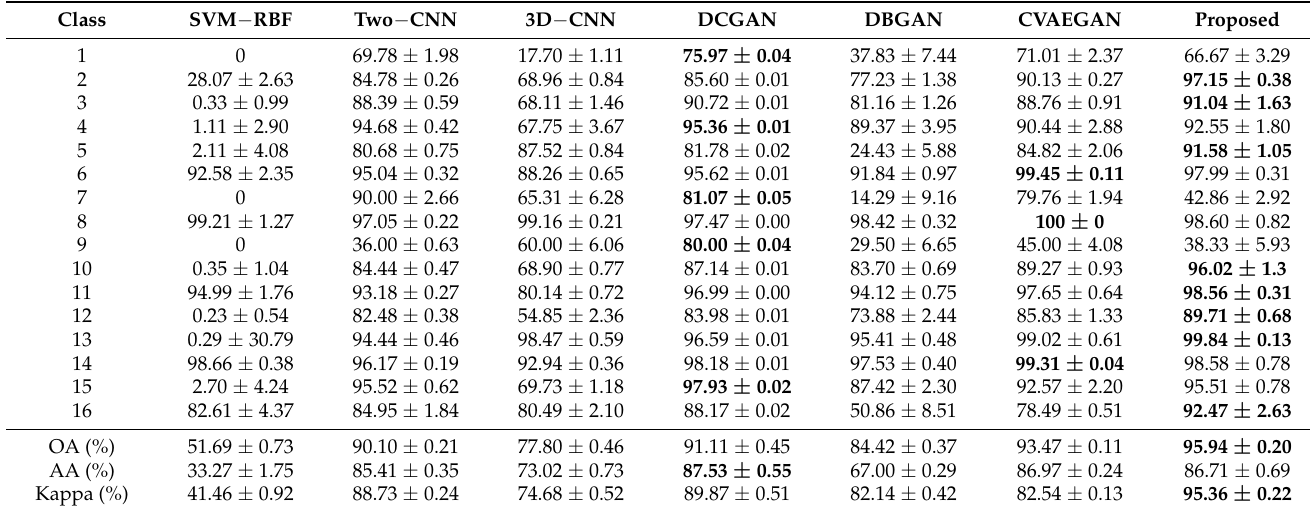
Table 9. Classification results on the Indian Pines data set.